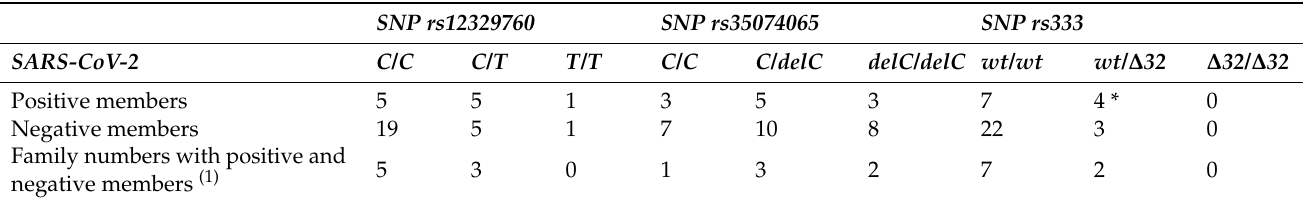
Table 3. Distribution of the genotypes in the analyzed